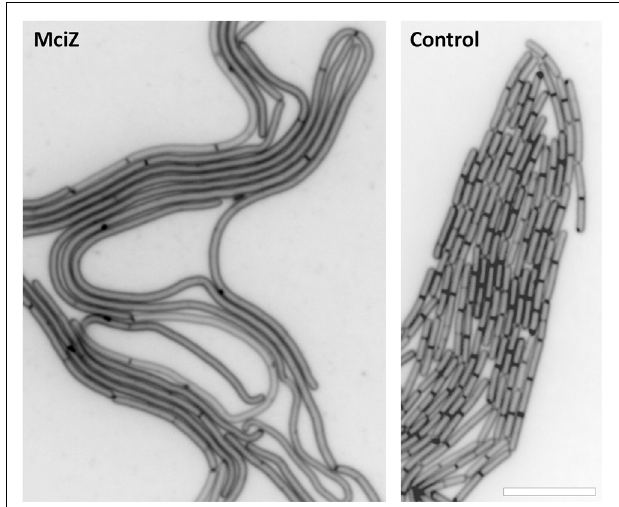
FIGURE 9 | Effect of synthetic MciZ on B. subtilis cell division. Cells were grown for two hours on Muller − Hinton broth agar medium in the presence or absence of 2.5 µ M MciZ in a Gene Frame system (Thermo Scientific). Membranes were visualized with FM4-64. Scale bar: 10 µ m.